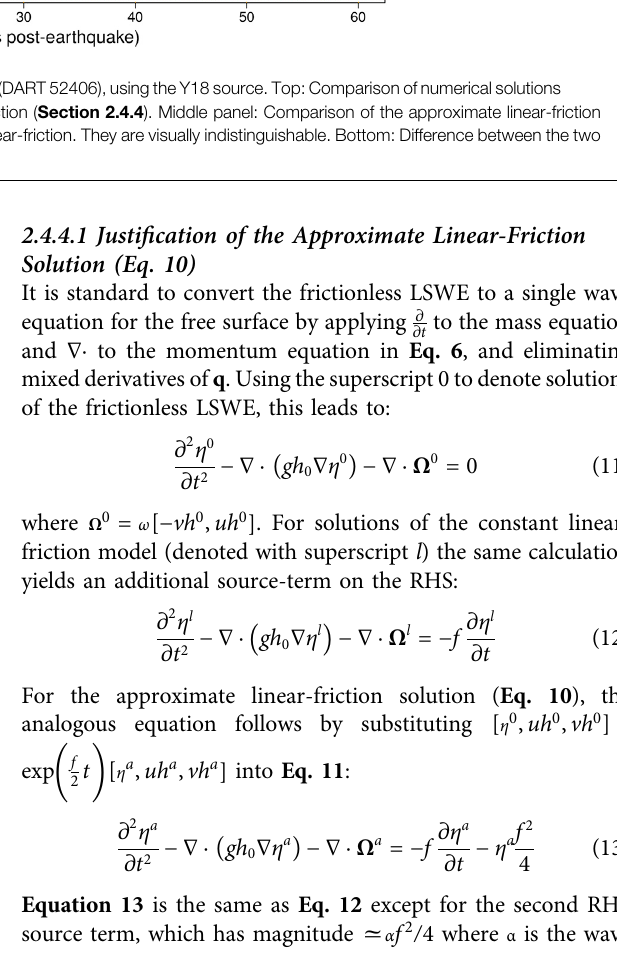
Frontiers in Earth Science |